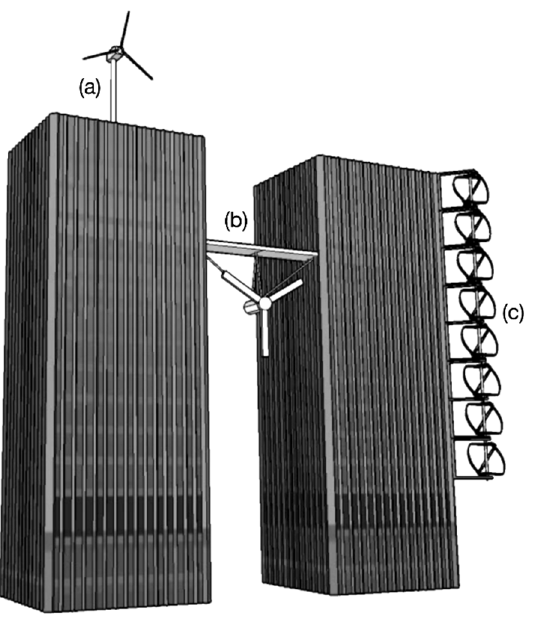
Figure 1. BIWT model and the possible location of wind turbines ( a ) on top of a building, ( b ) between two buildings, and ( c ) in the side of a building.